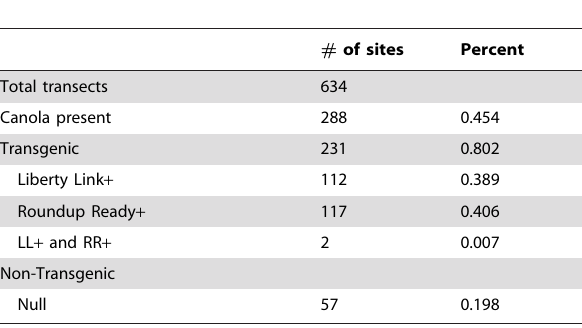
Table 1. Distribution of transgenic and non-transgenic canola in North Dakota